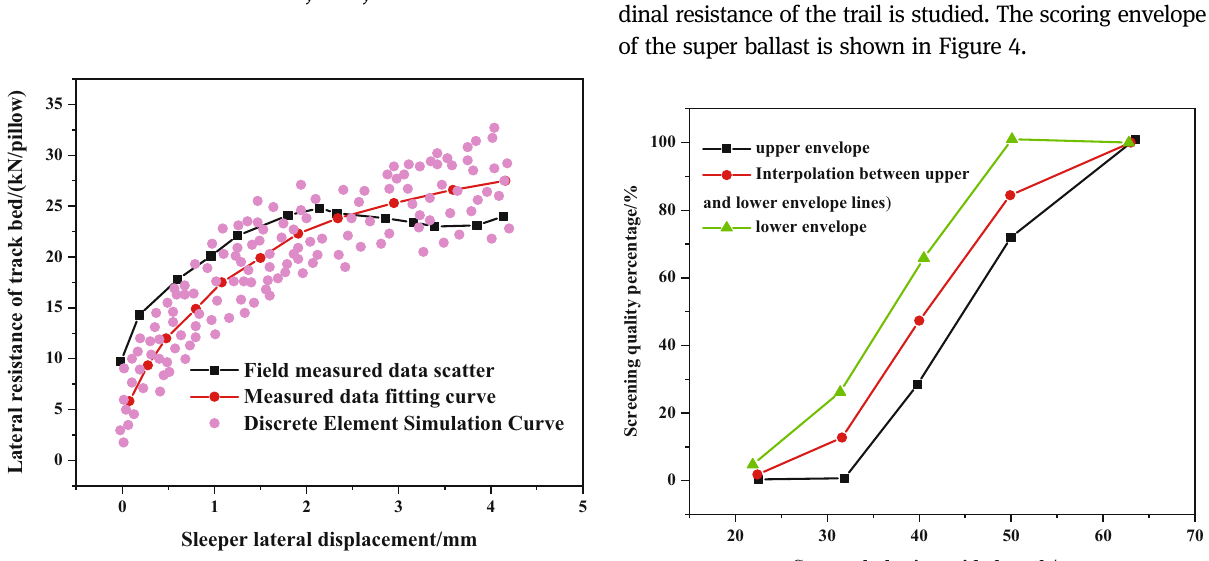
Figure 3: Test value and simulation value of longitudinal resistance of track bed. Figure 4: Grading envelope of super